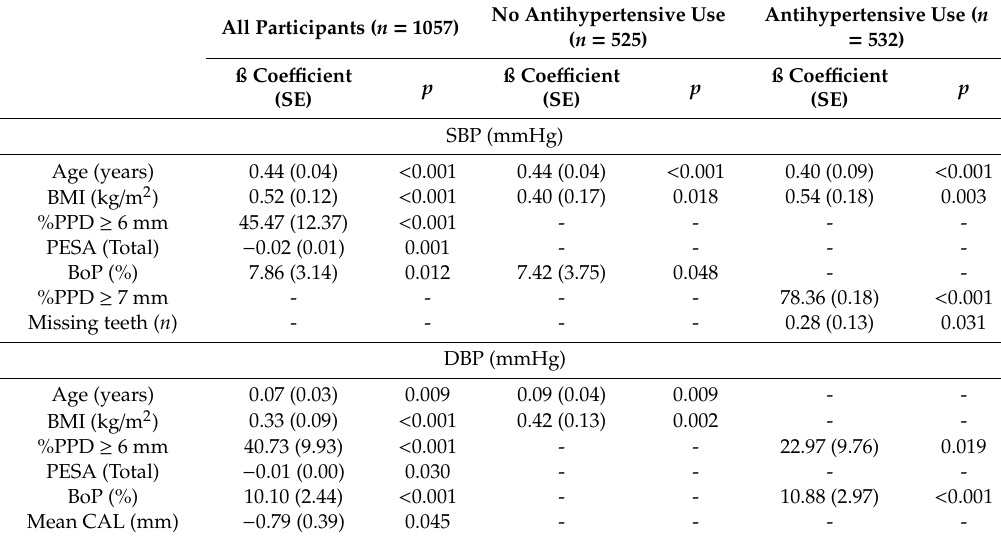
Table 3. Multiple unadjusted linear regression models for all participants and according to the use of antihypertensive medication towards Systolic Blood Pressure (SBP) and Diastolic Blood Pressure (DBP)